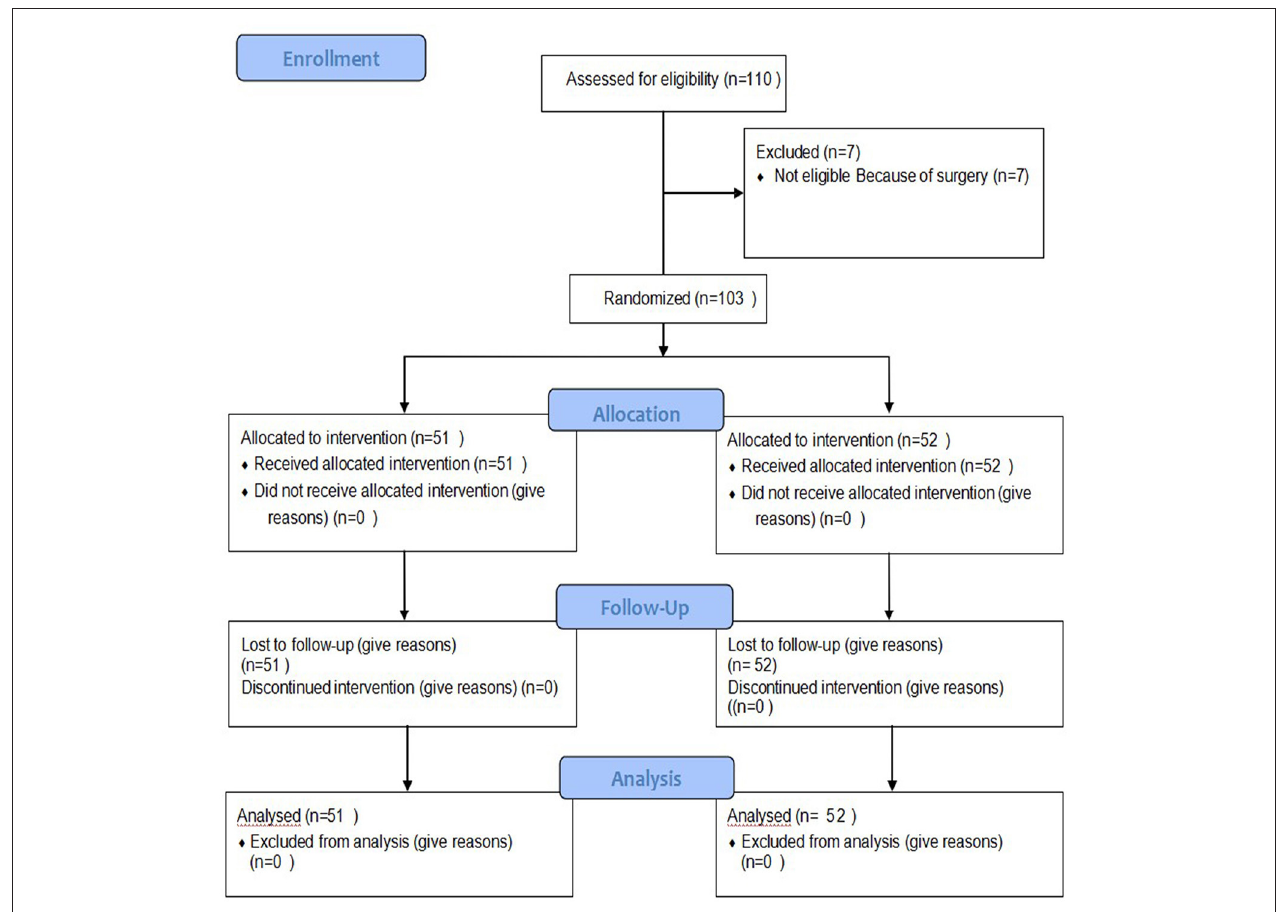
FIGURE 2 | CONSORT